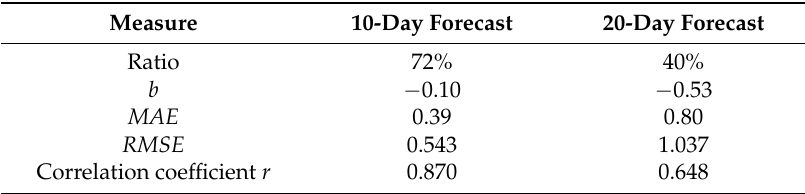
Table 6. Measures of accuracy for SPI value